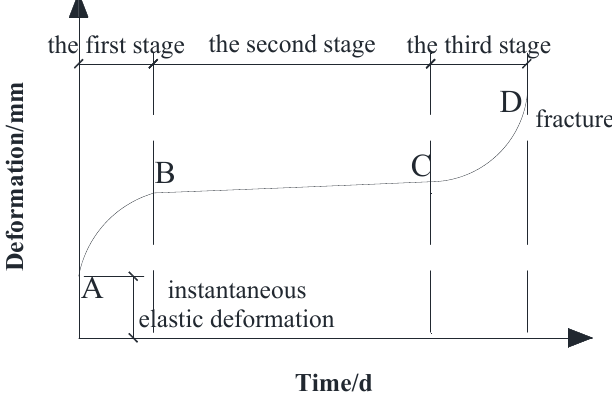
Figure 10. Diagram of the typical creep curve.